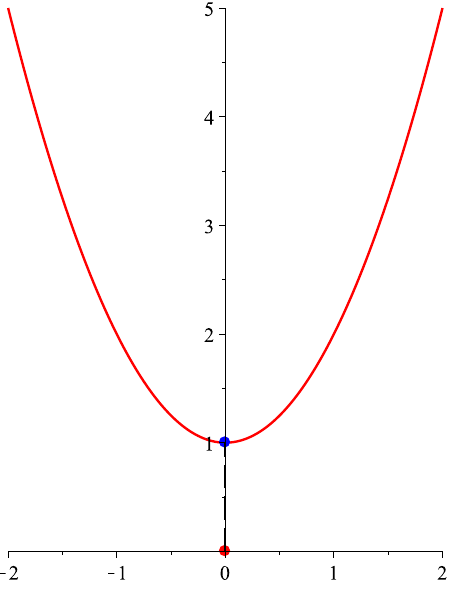
Figure 2. Geometric illustration for counterexample